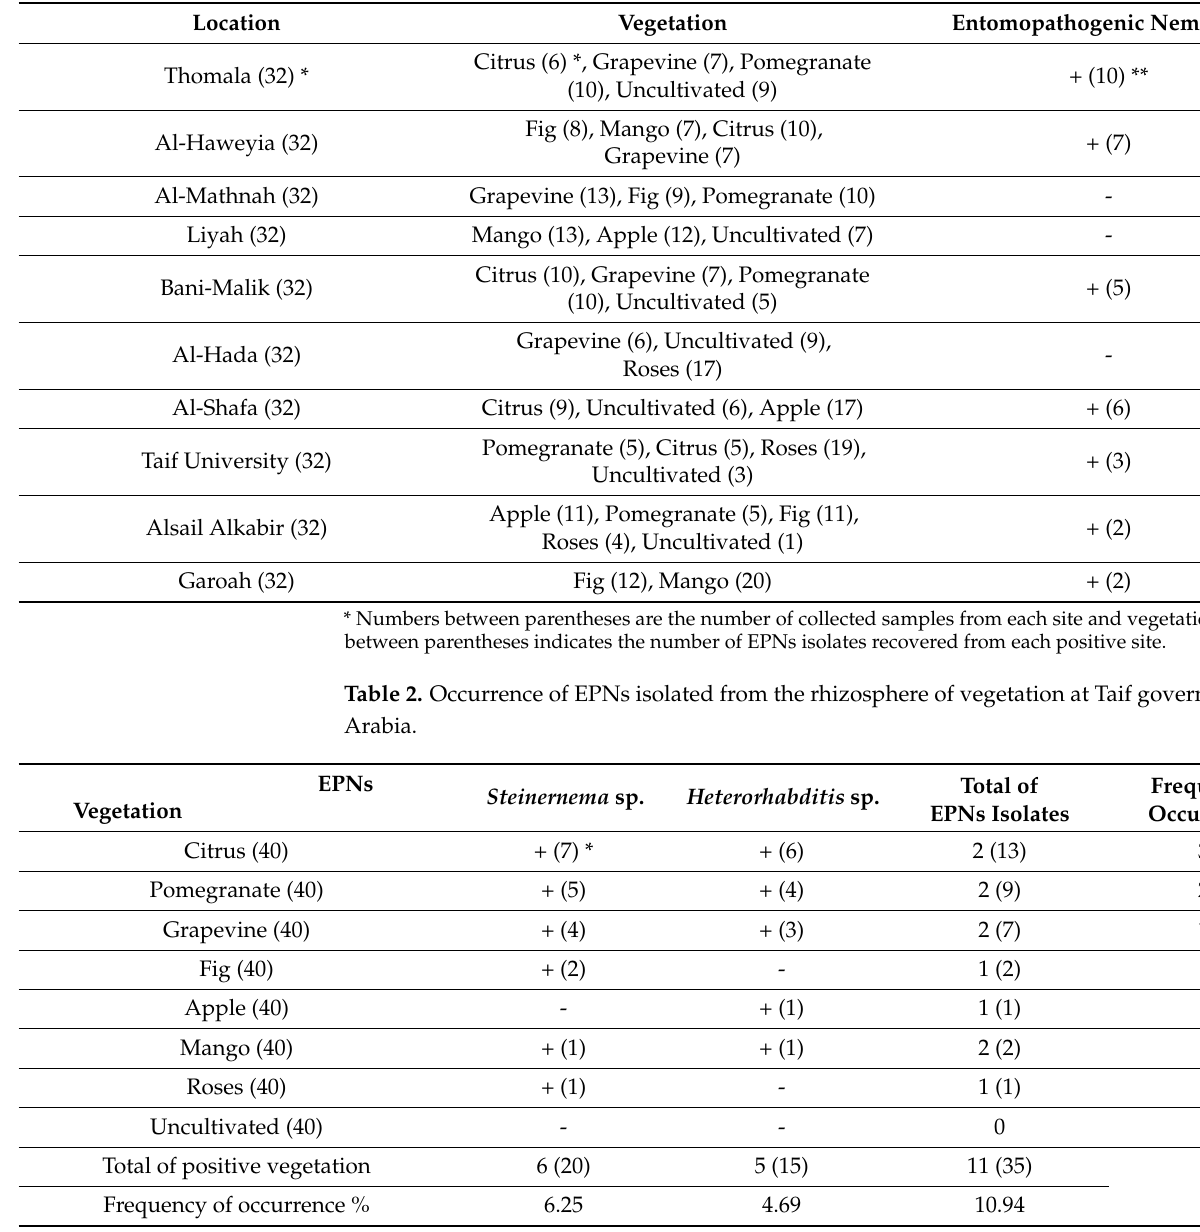
Table 1. Characterization of the vegetation and the sampling sites.